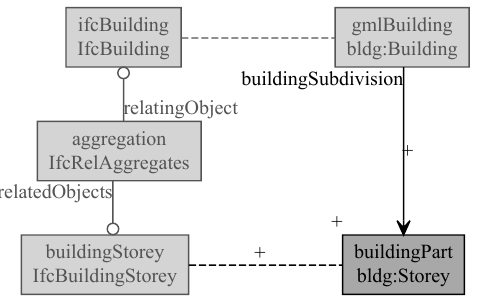
Figure 1. Forward transformation rule in old system